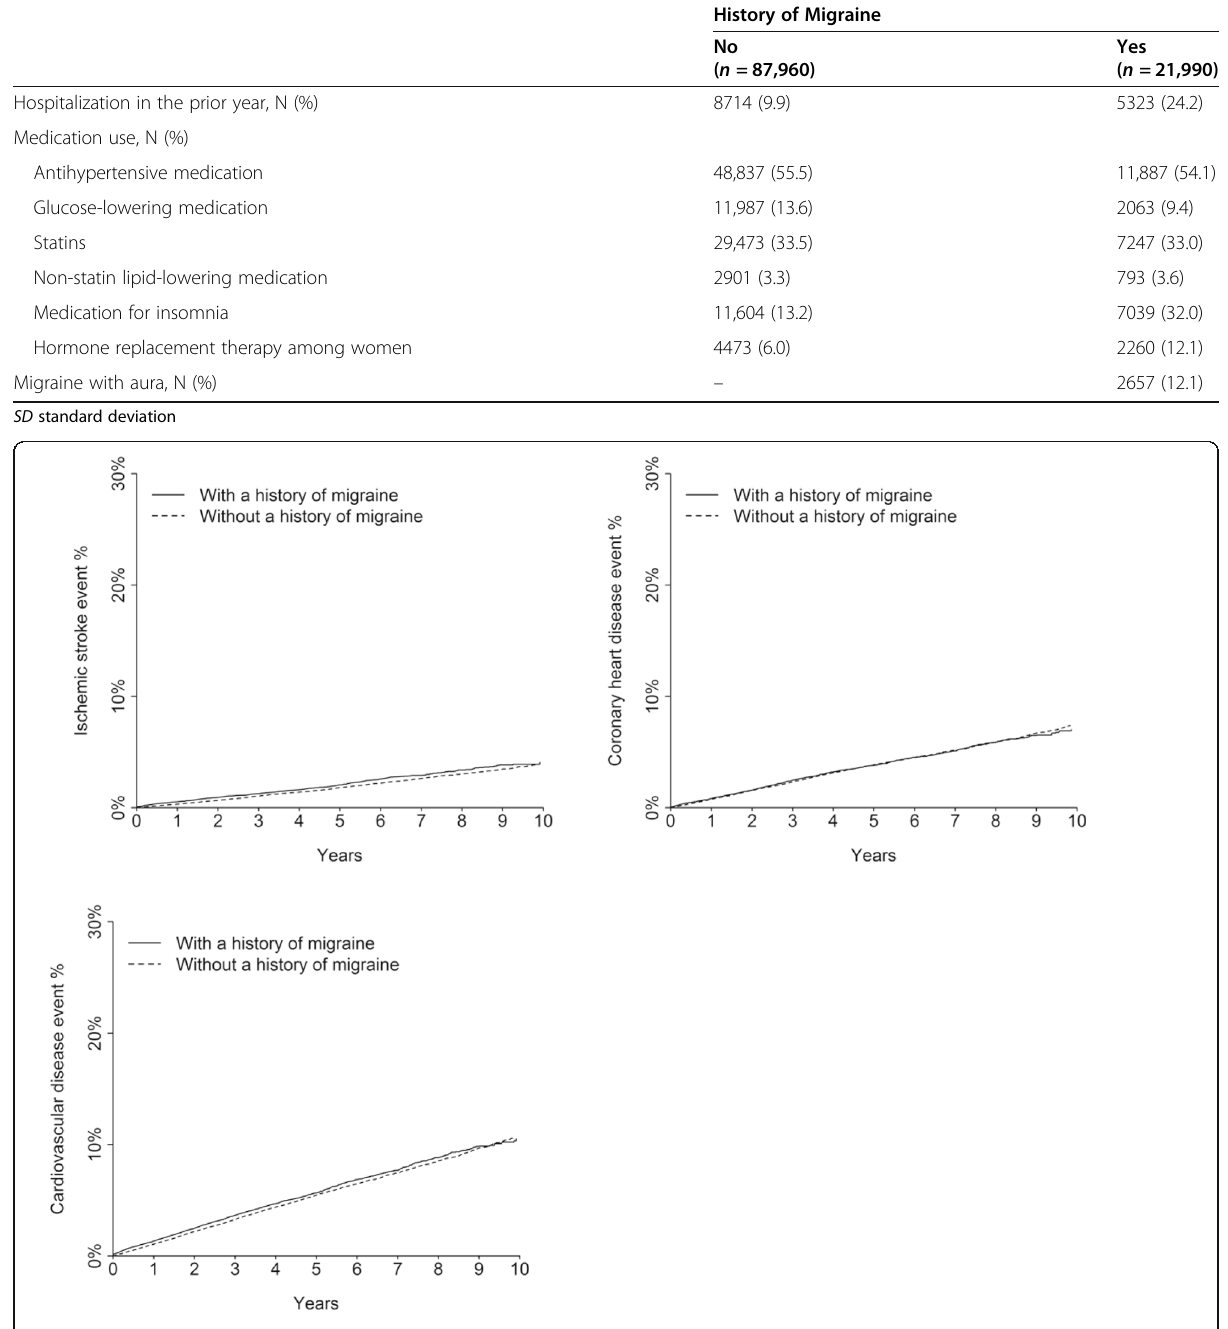
Table 1 Characteristics of patients without a history of cardiovascular disease who had and did not have a history of migraine (Continued)